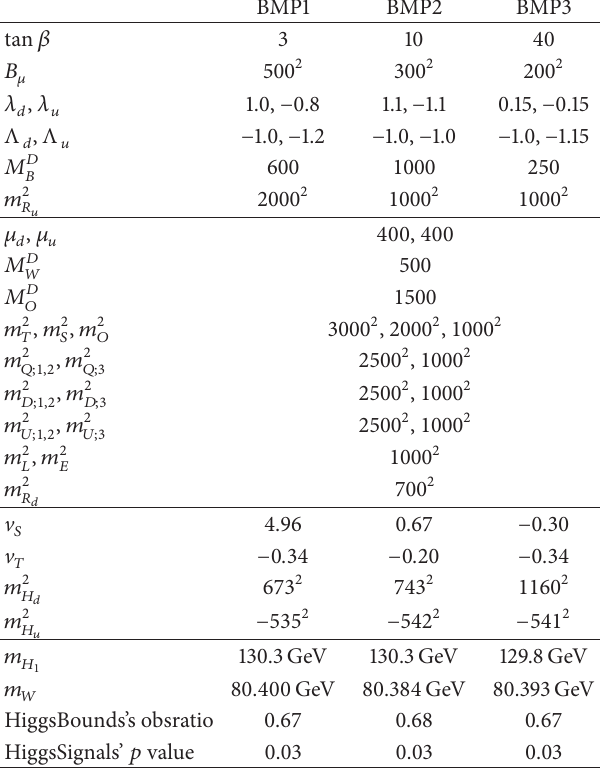
Table 2: Benchmark points of [17]. Dimensionful parameters are given in GeV or GeV 2 , as appropriate. The first two parts define input parameters. The third part shows parameters derived from electroweak symmetry breaking after solving the tadpole equations at two loops. The last part gives the theory predictions for the Higgs boson mass at the two-loop level and further quantities relevant to comparison with experiment.